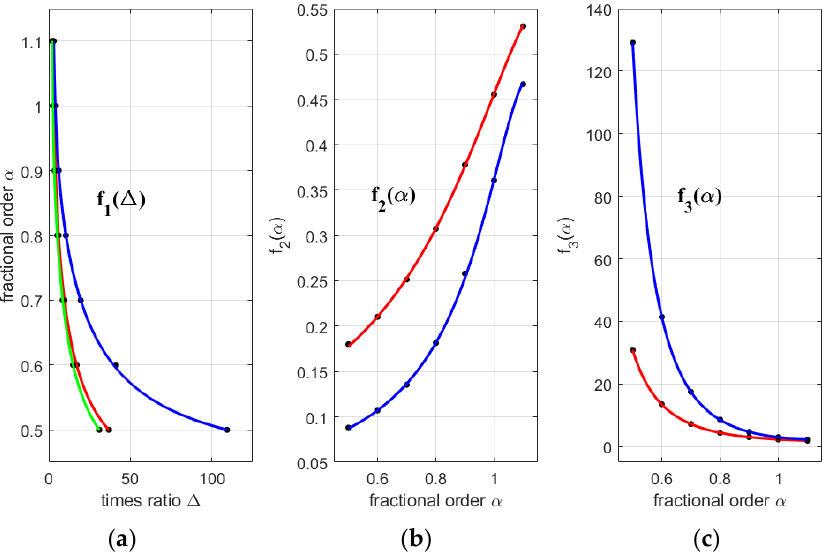
Figure 6. Data sets and results of curve fitting for asymmetrical sets of points, (10-55-90%), (20-60- 95%), and (20-75-95%), respectively: ( a ) Data sets {Δ, α} and curve fitting for f 1 (∆); ( b ) Data sets {α, a α } and curve fitting for f 2 (α); ( c ) Data sets {α, (τ x3 ) 1/α } and curve fitting for f 3 (α). Note that in each graph, curve fitting for (10-55-90%) is represented in red, (20-60-95%) in blue, and (20-75-95%) in green, respectively. Note also that sets #5 (20-60-95%) and #6 (20-75-95%) have the same functions f 2 (α) and f 3 (α).